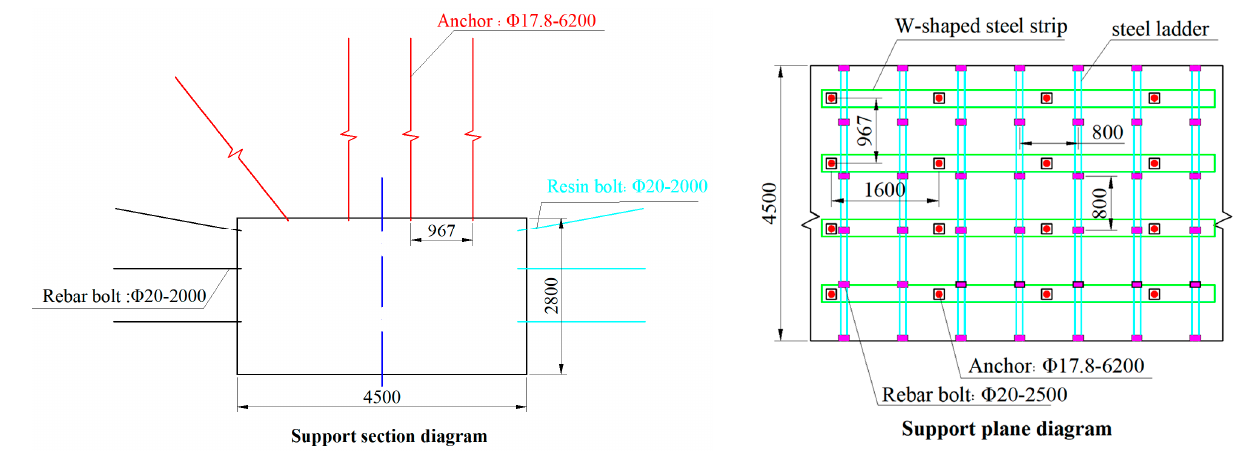
Figure 2. Original roadway support parameters.